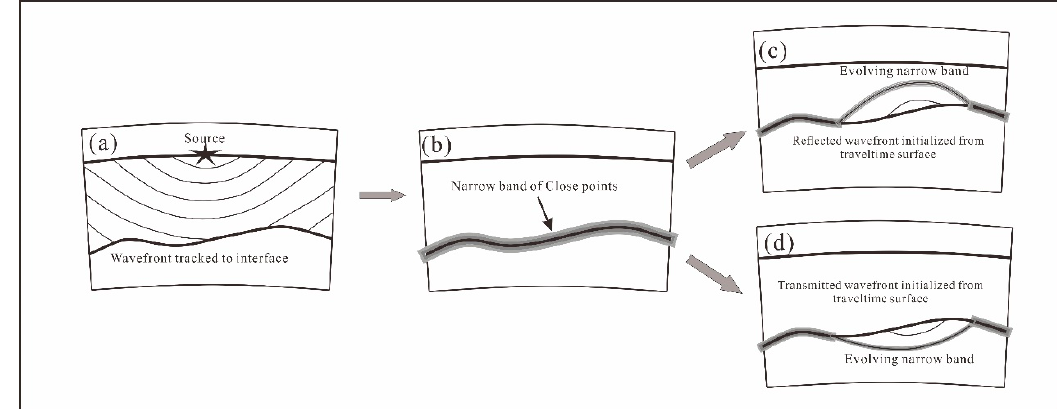
Figure 6. Illustration of the multi-stage Fast Marching Method (FMM) approach principle. The incident wave front is tracked to all points on the wave front, before reinitializing FMM in the incident or adjacent layer. (a) Incident wavefront generated from a point source; (b) Narrow band determined by a serial interface nodes; (c) reflected wavefront tracked; (d) refracted wavefront tracked [51].